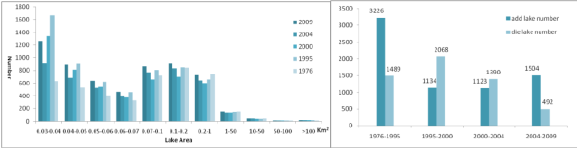
Fig.2 the Statistics of the Lakes in SRTR from 1976 to 2009 Fig.3 the Statistics of the new and died Lakes in SRTR